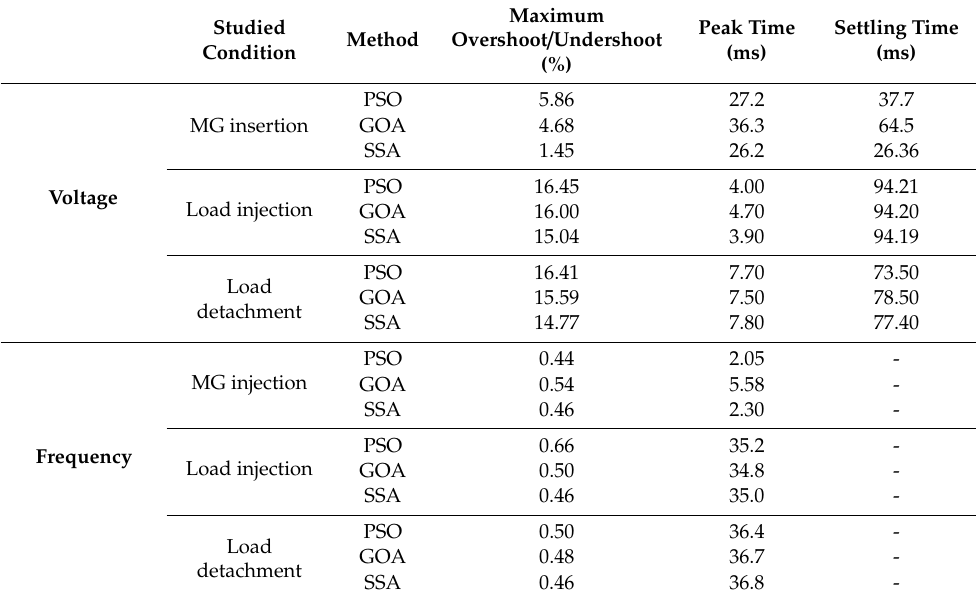
Table 3. Dynamic response evaluation of the proposed controller for voltage and frequency